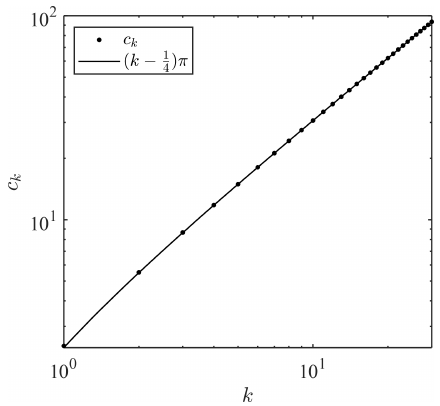
Figure 2. Positive zeros of the Bessel function of the first kind and zeroth order; J 0 (c k ) =